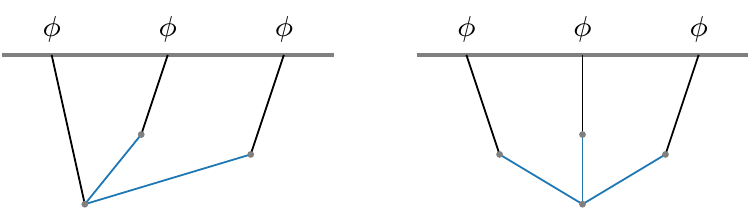
Figure 8 . The double-exchange ( left ) and triple-exchange ( right ) diagrams of the inflaton bispectrum. The blue internal lines are the exchanged massive field σ